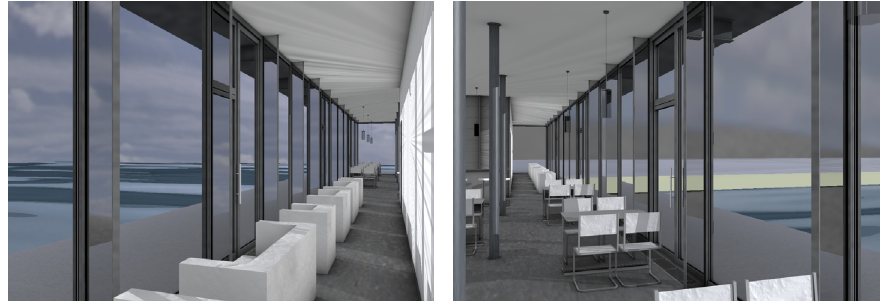
Figure 1 a and b: Application example of hybrid steel-glass beams